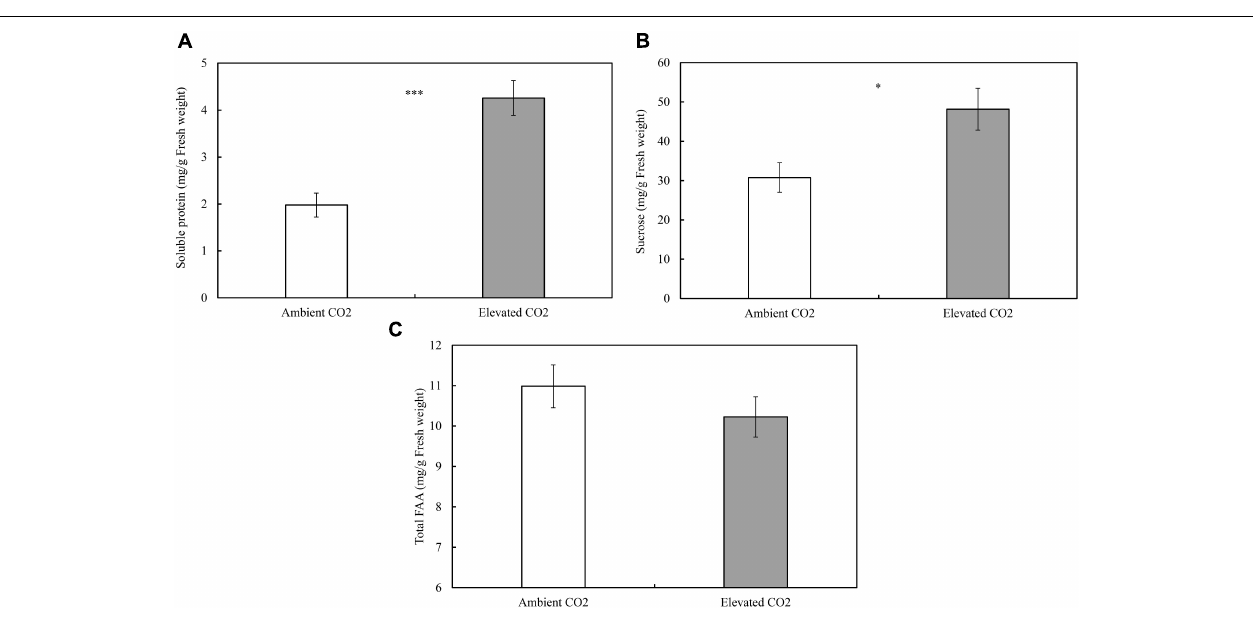
FIGURE 1 | Impacts of elevated CO 2 on the foliar contents of soluble constituents of cotton seedlings ( A : soluble proteins; B: sucrose; C : total free amino acids; asterisks indicate a significant difference between the treatments of ambient and elevated CO 2 by the LSD test at P < 0.05).